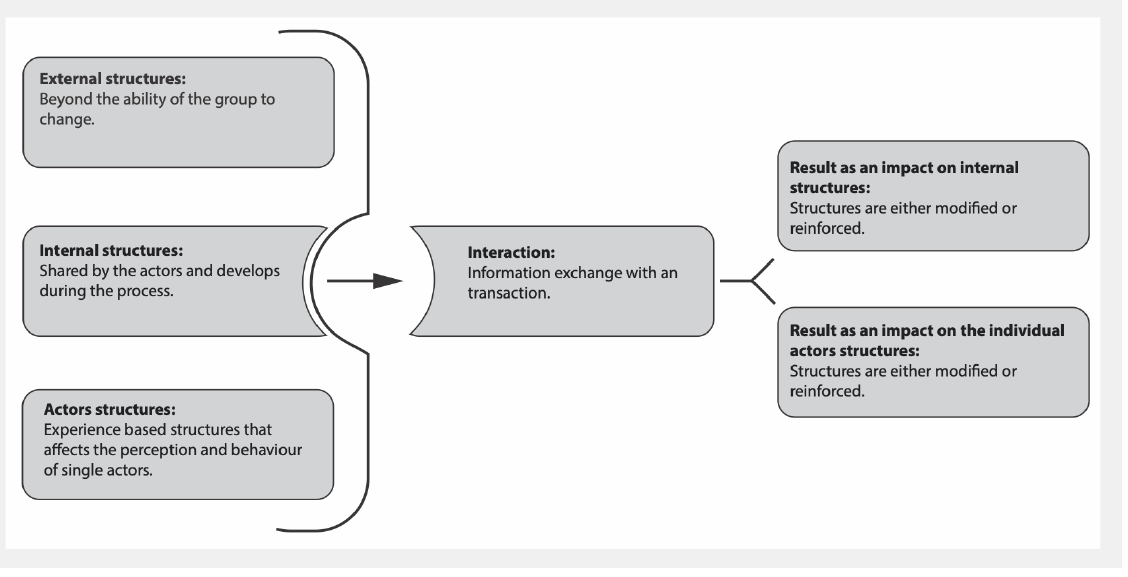
Fig. 3. The GroPro model from Backström, T. (2018): “How to understand and facilitate creative group processes – The GroPro